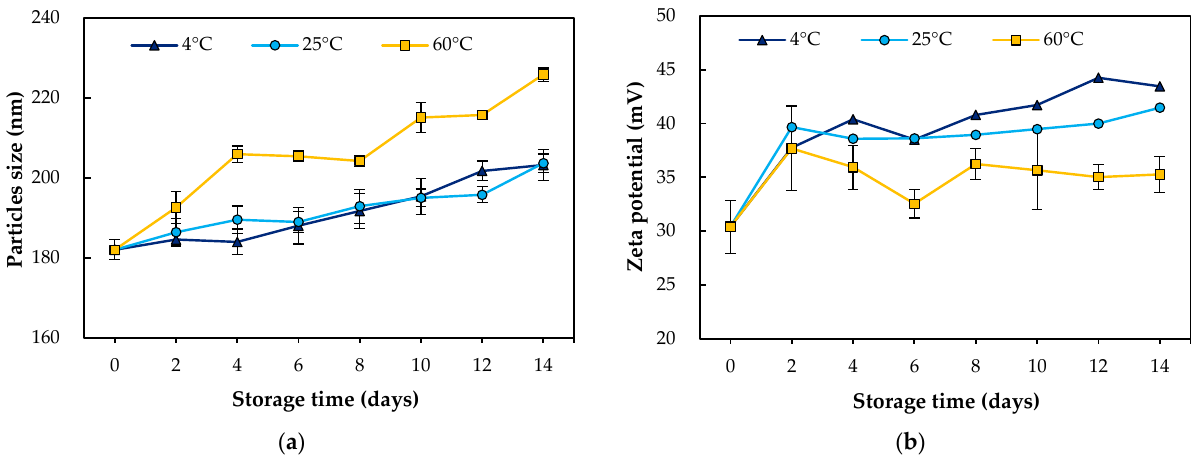
Figure 4. Effect of temperature on the physicochemical properties of the WCS-TE-NEs. ( a ) Particle size; ( b ) zeta potential of the WCS-TE-NEs.